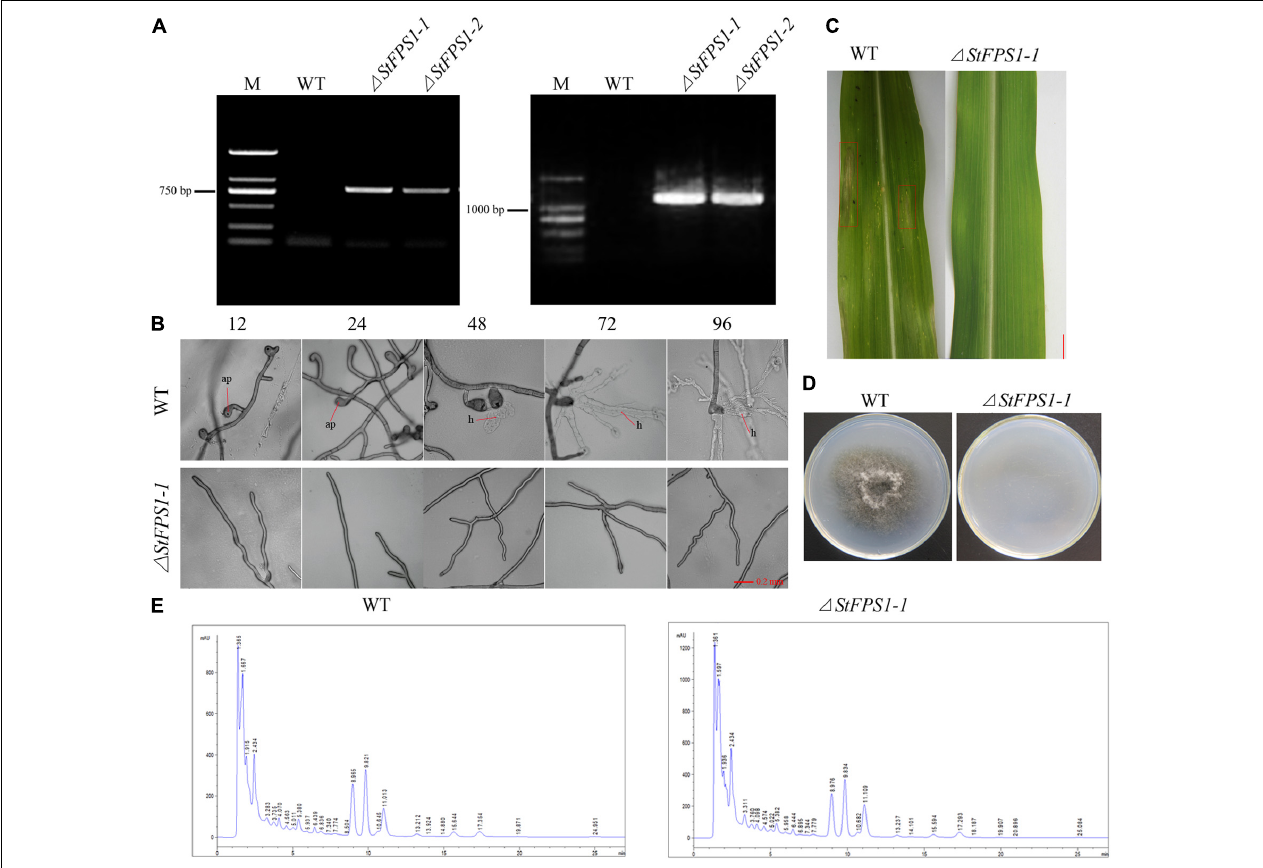
FIGURE 7 | Identification of the StFPS1 knockout mutant ( (cid:49) StFPS1 ) and functional analysis of (cid:49) StFPS1 . (A) S. turcica wild-type (WT) and (cid:49) StFPS1 , identified by amplifying a fragment of the hygromycin B phosphotransferase gene ( HPH ) using specific primers ( HPH -L/ HPH- R; left) and fragment including the StFPS1 upstream flanking fragment and HPH using specific primers ( StFPS1 -UpL/ HPH -UpR; right). (B) Observation of the appressorium development of WT and (cid:49) StFPS1 at 12, 24, 48, 72, and 96 h after inoculation under a microscope. (C) Mycelial suspensions were inoculated on maize B73 seedling whorl at the 4–6 leaf stage, and results were scored at 10 days post-inoculation, bar = 1 cm. (D) Comparison of the cellophane penetrating ability of WT and (cid:49) StFPS1 after the strains were incubated on cellophane at 25 ◦ C in the dark for 5 days and then removed the cellophane and continued to incubate for 2 days for observation. (E) High performance liquid chromatography analysis of HT-toxins of WT and (cid:49) StFPS1